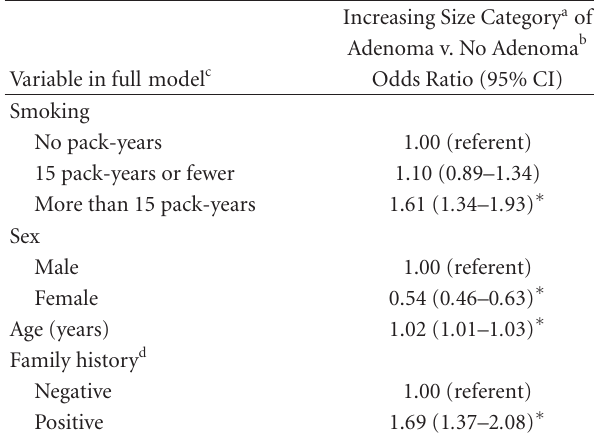
Table 5: An ordered logistic regression model of smoking and adenoma occurrence among individuals ( n = 5,395) undergoing screening colonoscopy in the New Hampshire Colonscopy Registry from